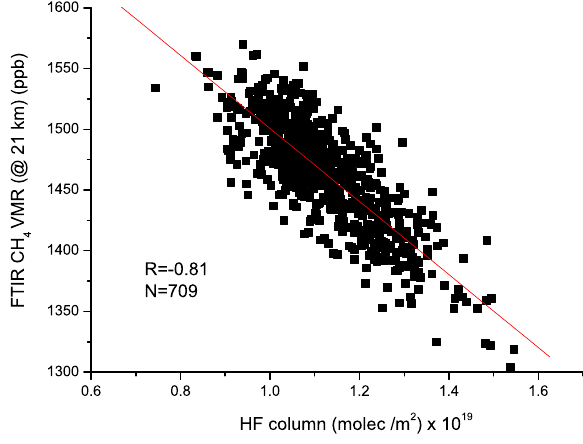
Fig. 8. Correlation plot of the retrieved total HF column versus CH 4 VMR in the UT/LS region (at 21km). The red line shows the linear regression